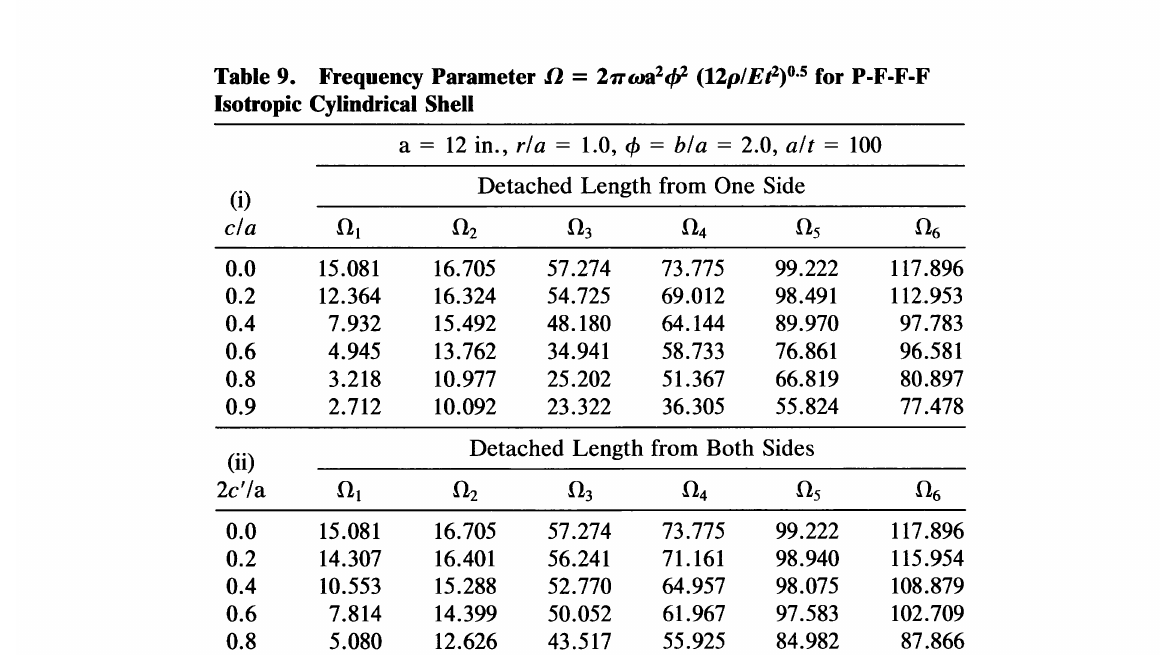
Table 9. Frequency Parameter n = 2'TTwa 2 4JZ (UpIEP)o.s for P-F-F-F Isotropic Cy6ndrical